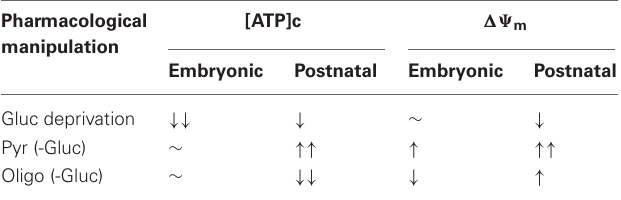
Table 1 | Comparison of the major differences of embryonic and postnatal hippocampal cultured